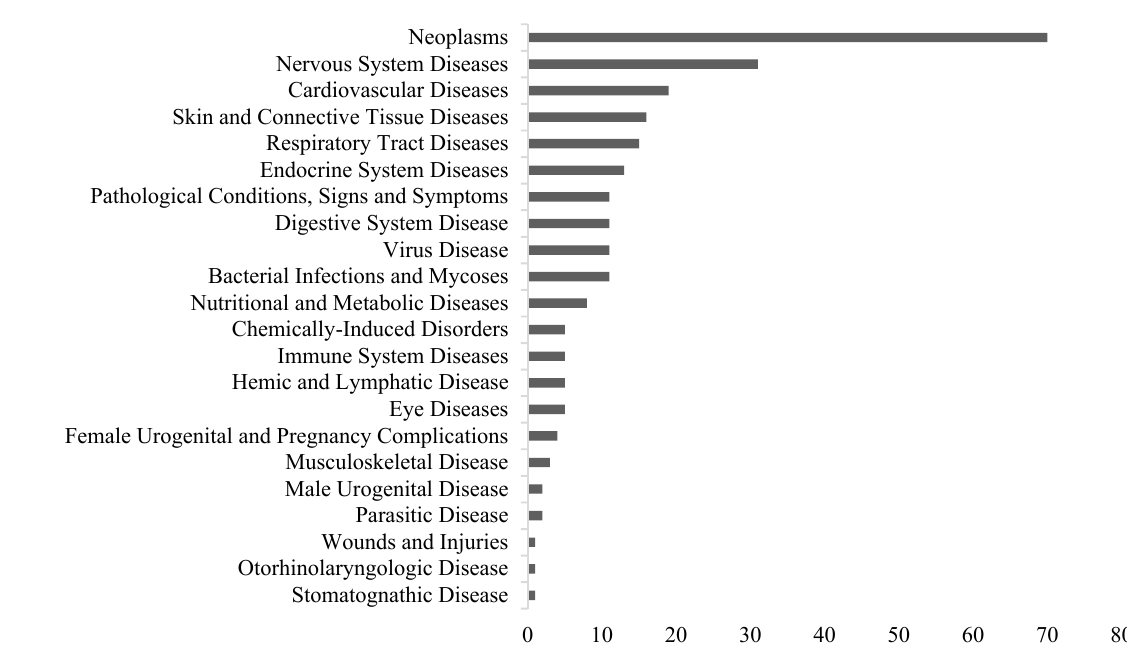
Figure 1. Expedited designations granted to new molecular entities (NMEs) approved the FDA from 2011–2017, divided by therapeutic area.